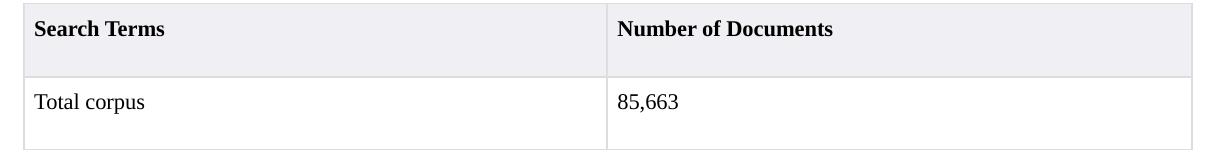
Table 1. Number of documents in subcorpora. (See also Figure